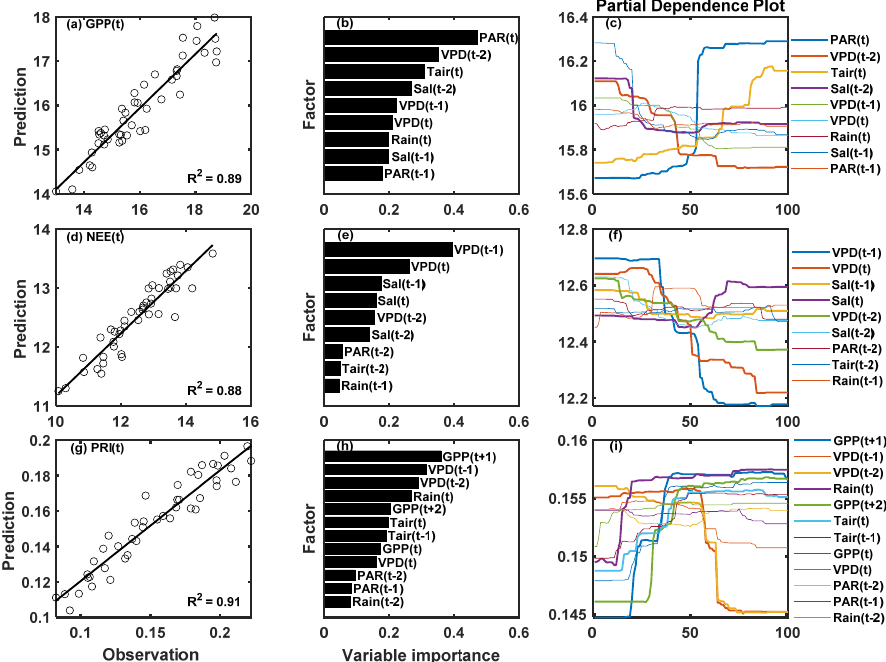
Figure 7. The regression performance ( a , d , g ) of three sets of random forest (RF) analyses and their quantification of relative importance ( b , e , h ) and affecting direction ( c , f , i ) for explanatory variables